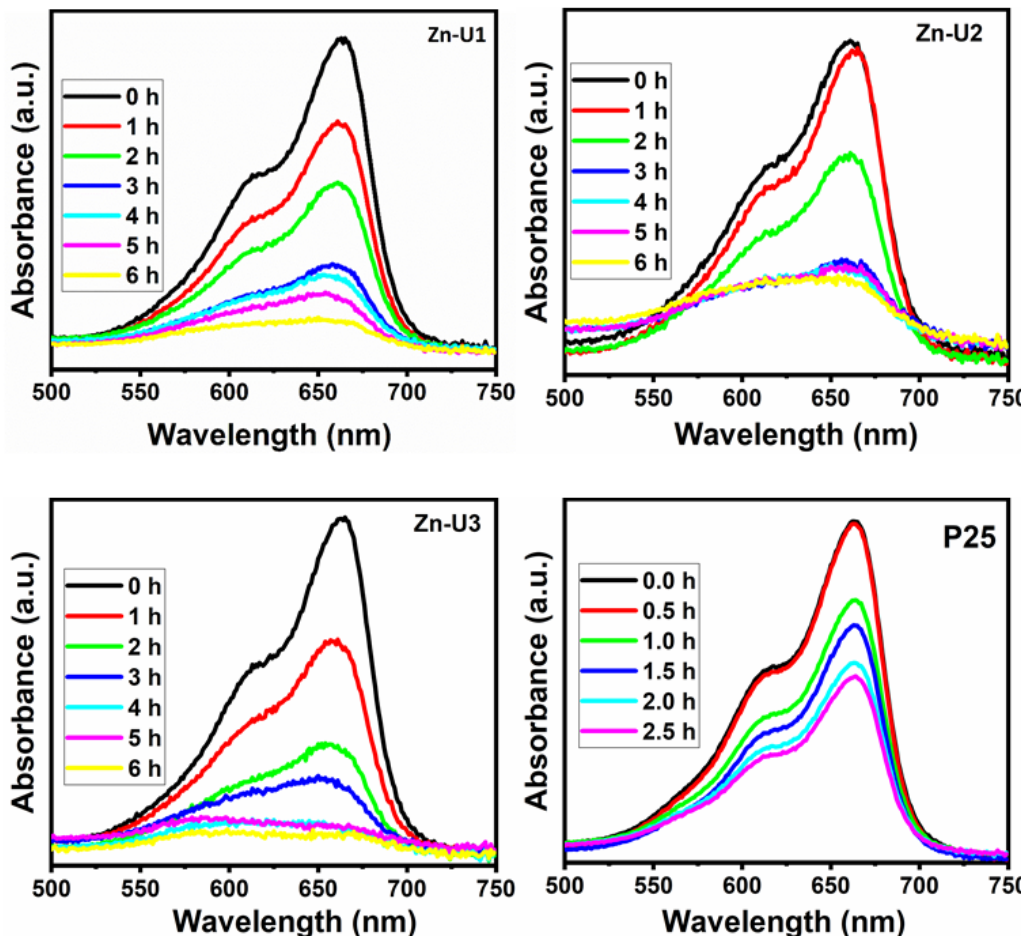
Figure 7. Time dependent spectral change of Methylene Blue (MB) solution catalyzed by Zn-U1, Zn-U2, Zn-U3 and P25 photocatalysts under UV-light irradiation.